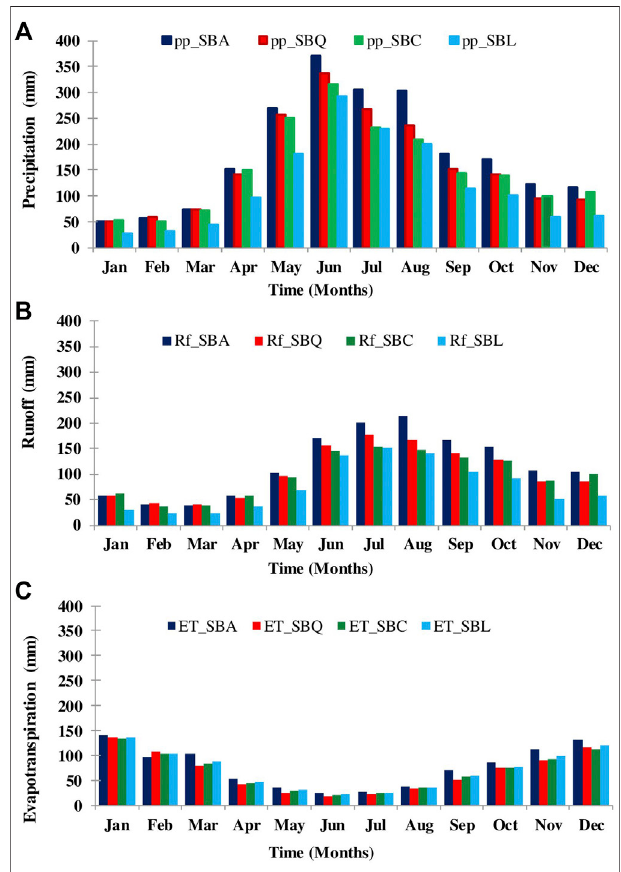
FIGURE 6 | Results of the WEAP simulations: Calculated terms of the monthly water balance for each sub-basin (mm). (A) Precipitations (pp). (B) Runoff (Rf). (C) Evapotranspiration